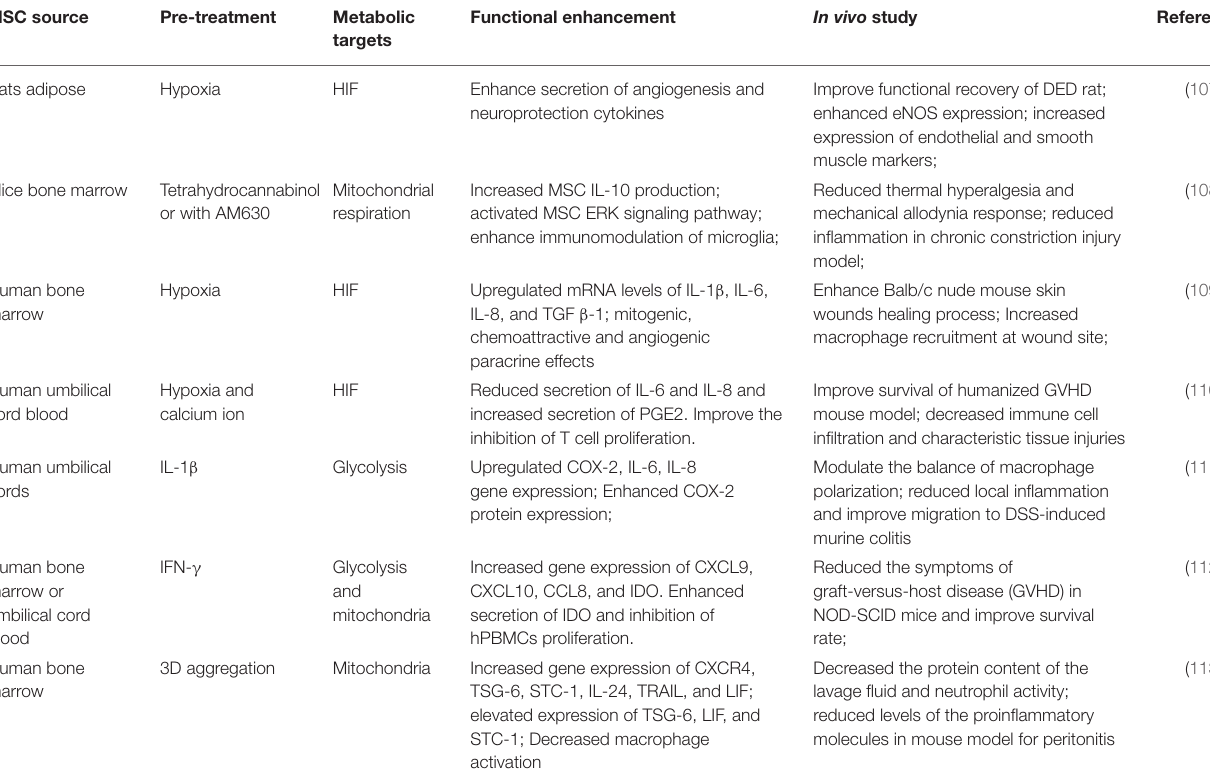
TABLE 1 | Metabolic enhancement of mesenchymal stem cell-mediated immunomodulation in preclinical studies. MSC